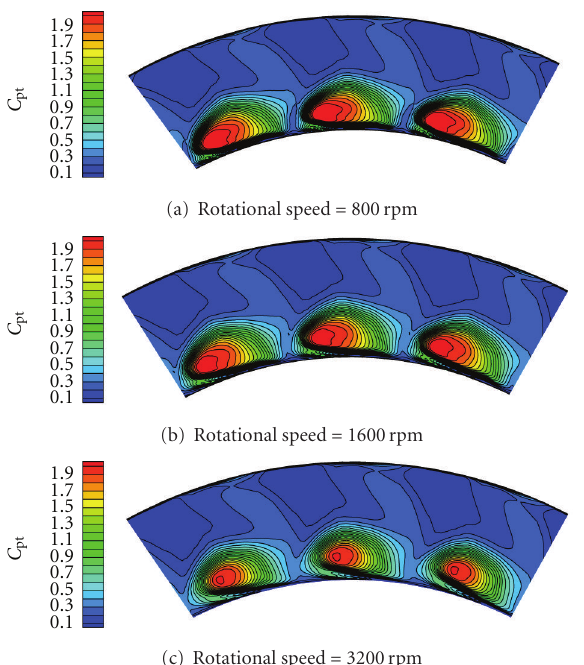
Figure 14: Total pressure coe ffi cient at di ff erent rotational speeds.